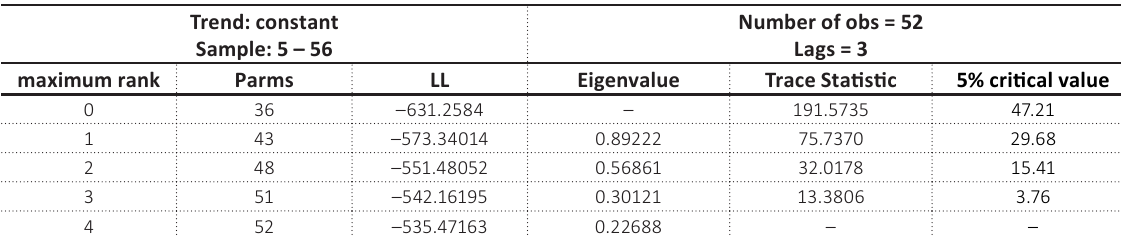
Table 4. Johansen tests for cointegration